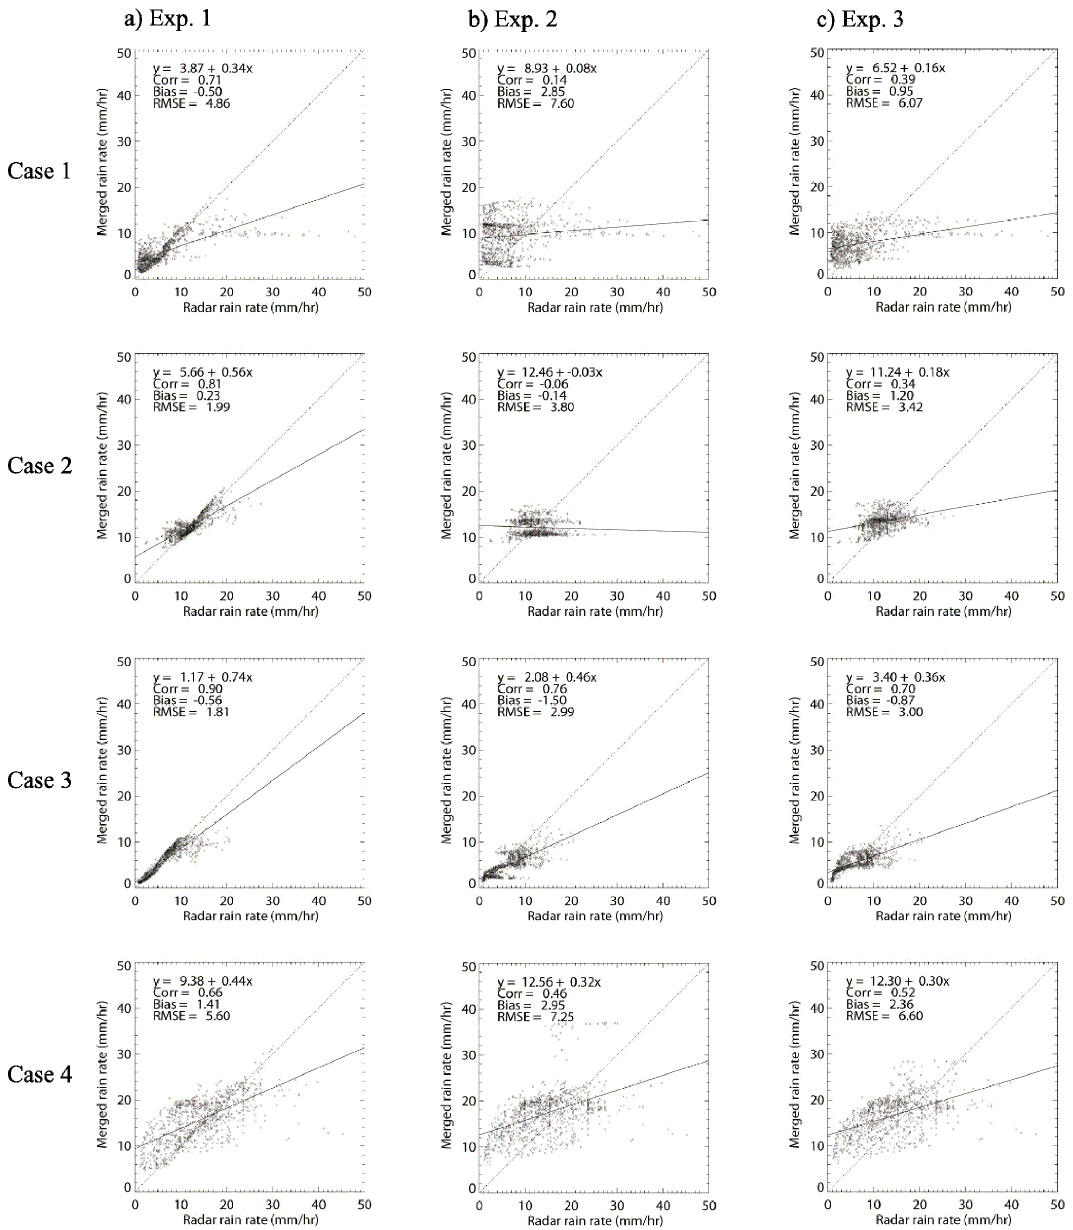
Figure 8. Scatter diagrams for the radar rain rate estimations vs. the merged precipitation over the radar gap areas using the merging methods of (a) optimal weight using radar, (b) optimal weight using AWS, and (c) equal weight for each of the precipitation